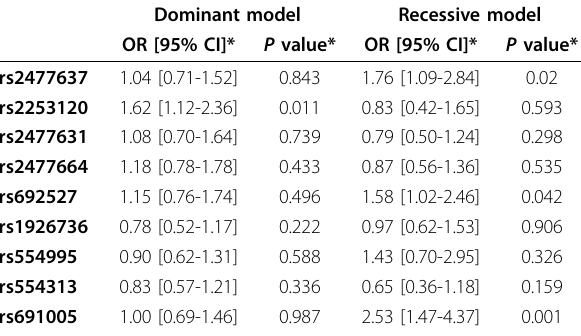
Table 4 Odds ratios (OR) and P values for 9 SNPs in MRC1 among subjects with sarcoidosis and control subjects Dominant model Recessive